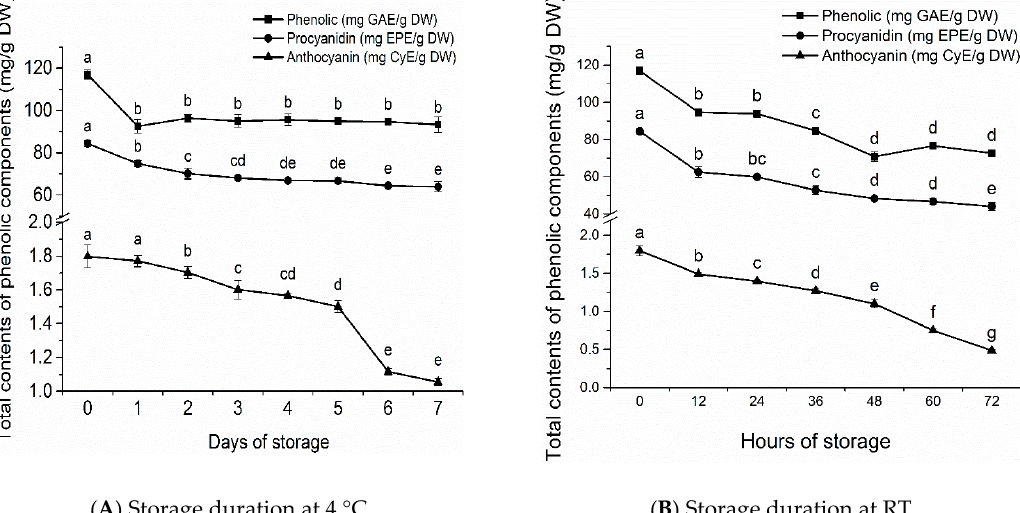
Figure 1. Changes of total contents of phenolic, procyanidin, and anthocyanin in litchi pericarp during storage at 4 °C ( A ) and at room temperature (RT) (27 ± 2 °C) ( B ). Values are expressed as means ± SD, n = 3. Different letters at different storage time are significantly different, p < 0.05.